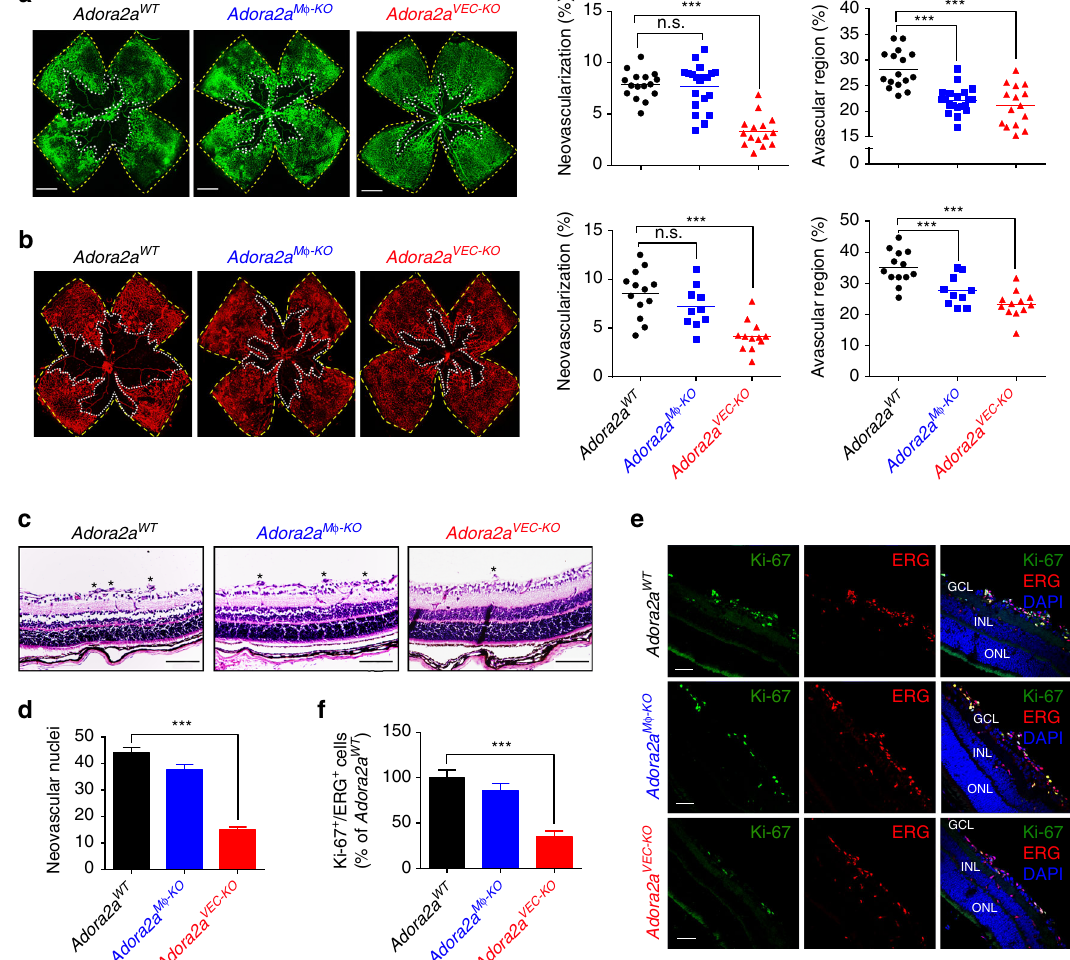
Fig. 2 Endothelial Adora2a de fi ciency signi fi cantly decreases formation of pathological neovascularization in OIR retinas. a , b Quanti fi cation of pathological neovascularization and vessel dropout area (within the white borders ) in postnatal day (P)17 OIR retinas. Adora2a fl ox/ fl ox ( Adora2a WT ), Adora2a fl ox/ fl ox Lysm cre/cre ( Adora2a M φ -KO ), and Adora2a fl ox/ fl ox Cdh5 cre ( Adora2a VEC-KO ) mice were exposed to 70% O 2 a or 75% O 2 b . Areas of pathological neovascularization and vessel dropout are quanti fi ed as percentage of total retinal area. n = 16, 20, 15 retinas for a ; n = 13, 10, 12 retinas for b ; *** P < 0.001 vs. Adora2a WT group. Scale bars : 1000 μ m. c Histological analysis of in fi ltration of neovascular nuclei from inner limiting membrane into vitreous in the OIR retinas. Nuclei on the vitreal side of the inner limiting membrane are indicated by asterisk . Scale bars : 100 μ m. d Quantitative analysis of the number of neovascular nuclei in the OIR retinas. * P < 0.001 ( n = 6 mice for Adora2a WT group; n = 8 for Adora2a M φ -KO and Adora2a VEC-KO groups). e Ki-67 immuno fl uorescent staining on OIR retinas. Representative green (Ki-67), red (ERG), blue (nuclei, DAPI), and merged images were captured with confocal fl uorescent microscopy. GCL ganglion cell layer, INL inner nuclear layer, ONL outer nuclear layer. Scale bars : 50 μ m. f Quantitative analysis of the Ki-67 and ERG double-positive cells in each group. * P < 0.001 ( n = 9 mice for each group). Data are represented as means ± s.e.m. Statistical signi fi